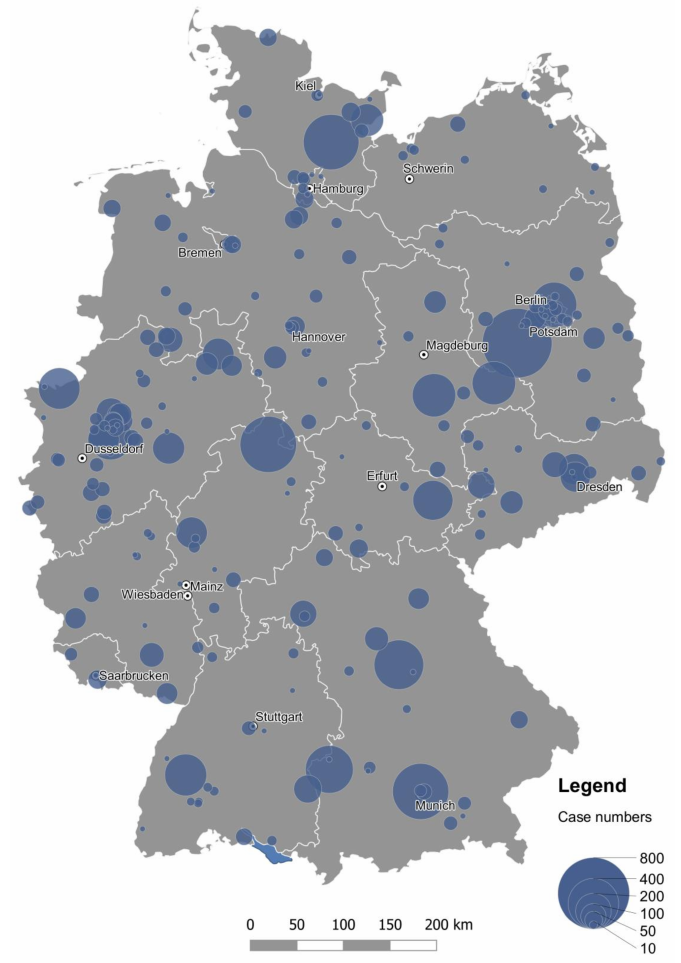
Figure 8. Area-proportional representation of PD-MCT case numbers in German hospitals in